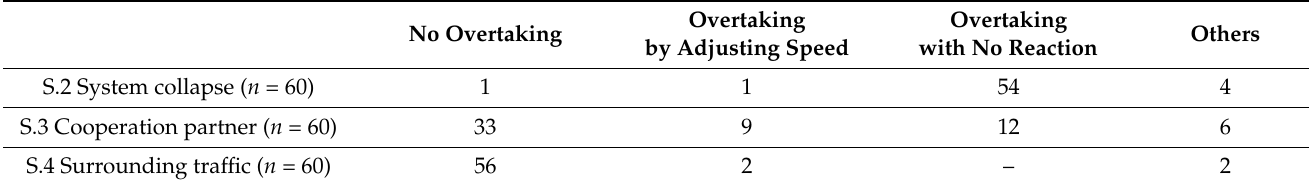
Table 3. Summary of respective reactions as soon as an abort situation occurred.